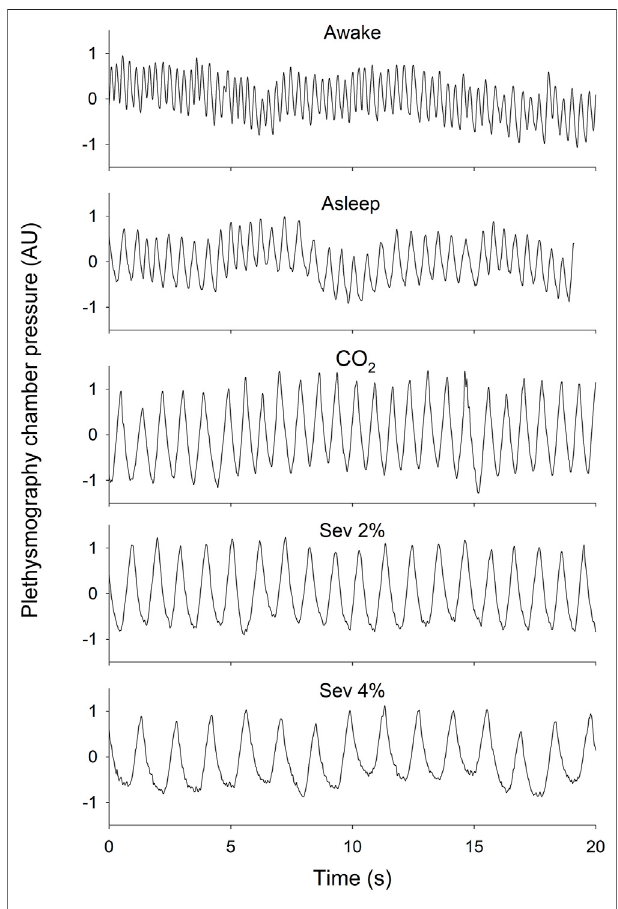
FIGURE 1 | Representative 20-s tracings of plethysmography chamber pressure in wakeful (Awake) and sleeping (Asleep) states, and during the inhalation of 5% CO 2 (CO 2 ), 2% sevo fl urane (Sev 2%) or 4% sevo fl urane (Sev 4%) with the baseline pressure adjusted to 0. Scaling of the y-axes are